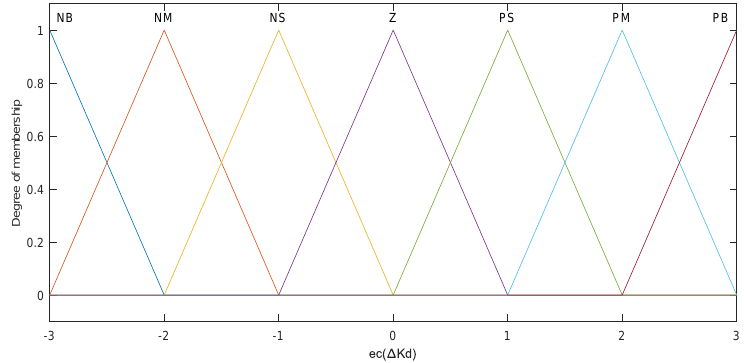
Figure 9. Membership function curve of various ec and ∆ K d .